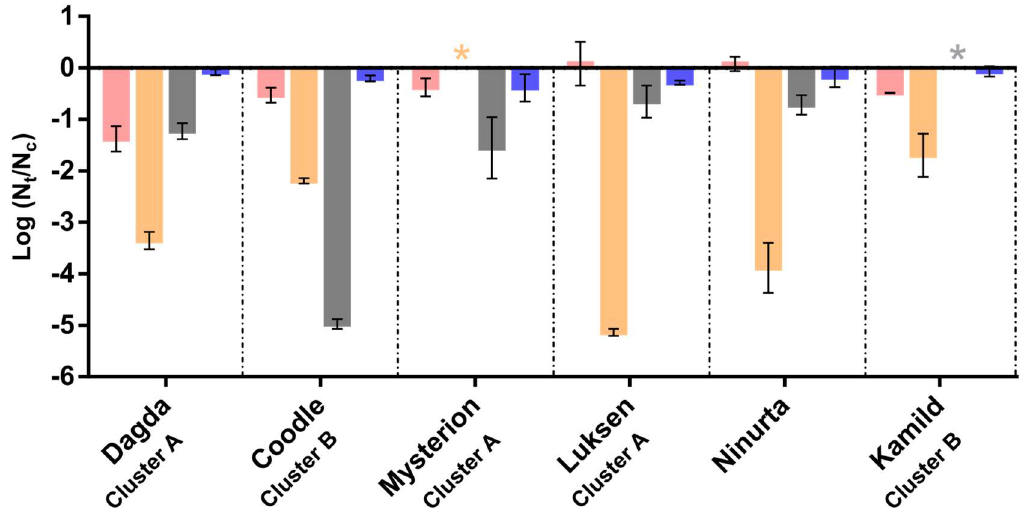
Figure 3. Stability assay: Effect of 20% ethanol (red), UV radiation (orange), three freeze/thaw cycles (grey) and chloroform (blue) in vitro on the stability of six phages used in the phage cocktail. Values indicate the titer post exposure relative to the control. Error bars indicate ± SD. Asterisks indicate titers below the detection limit.